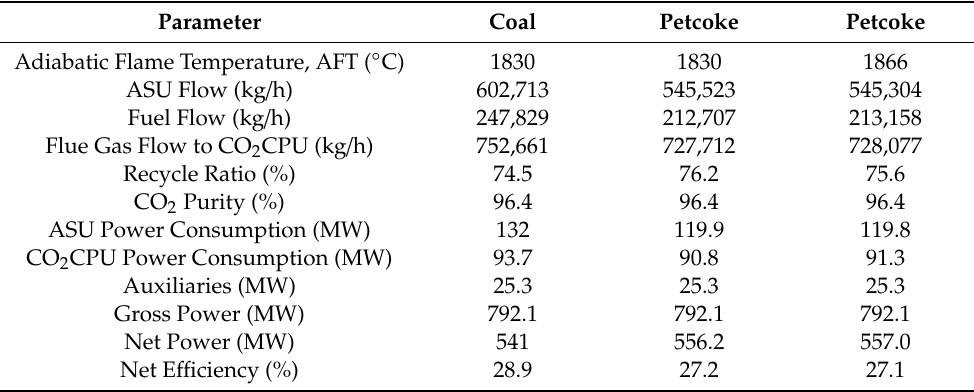
Table 3. Comparison of simulation results for the oxy-combustion of coal and